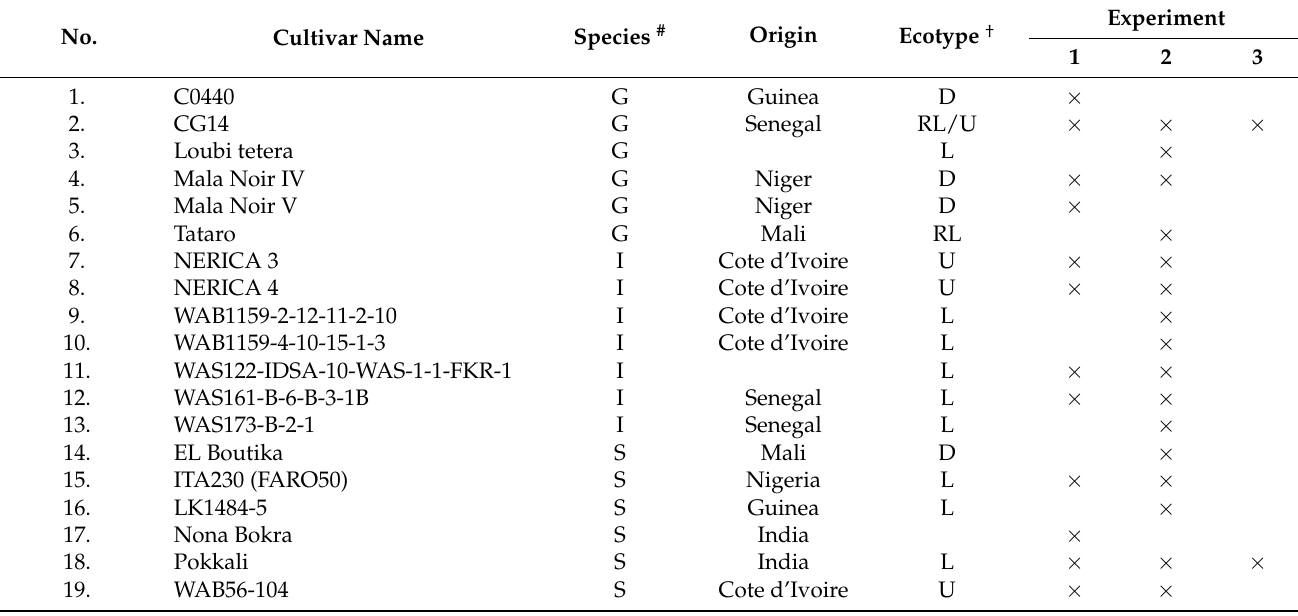
Table 2. Origins and ecotypes of rice genotypes used in different salinity tolerance assessment